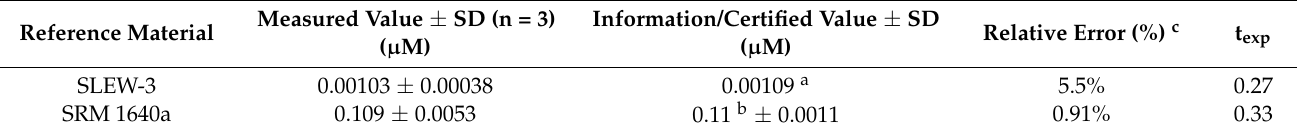
Table 3. The results of U(VI) determination in reference materials.